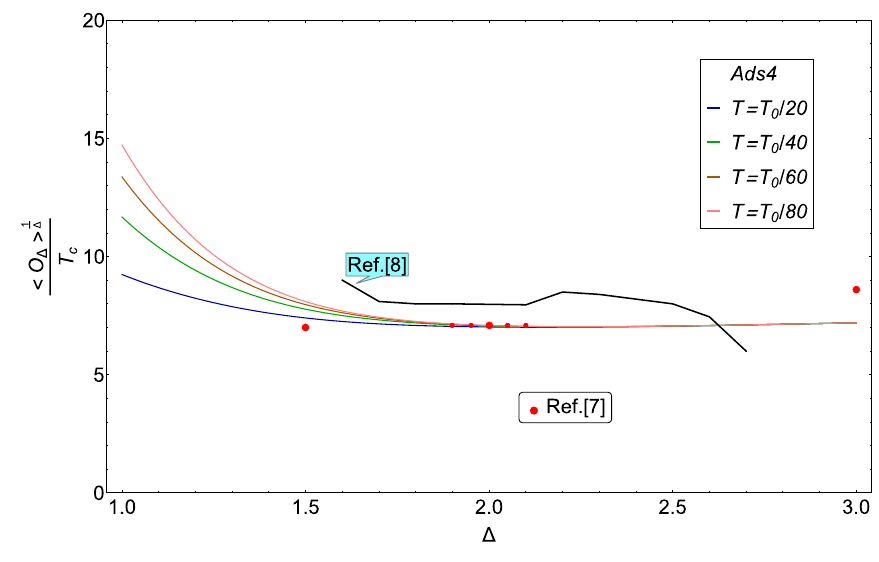
Fig. 7 (cid:3) O (cid:2) (cid:4) 1 (cid:2) / T c vs (cid:2) for d = 3. Smooth colored lines